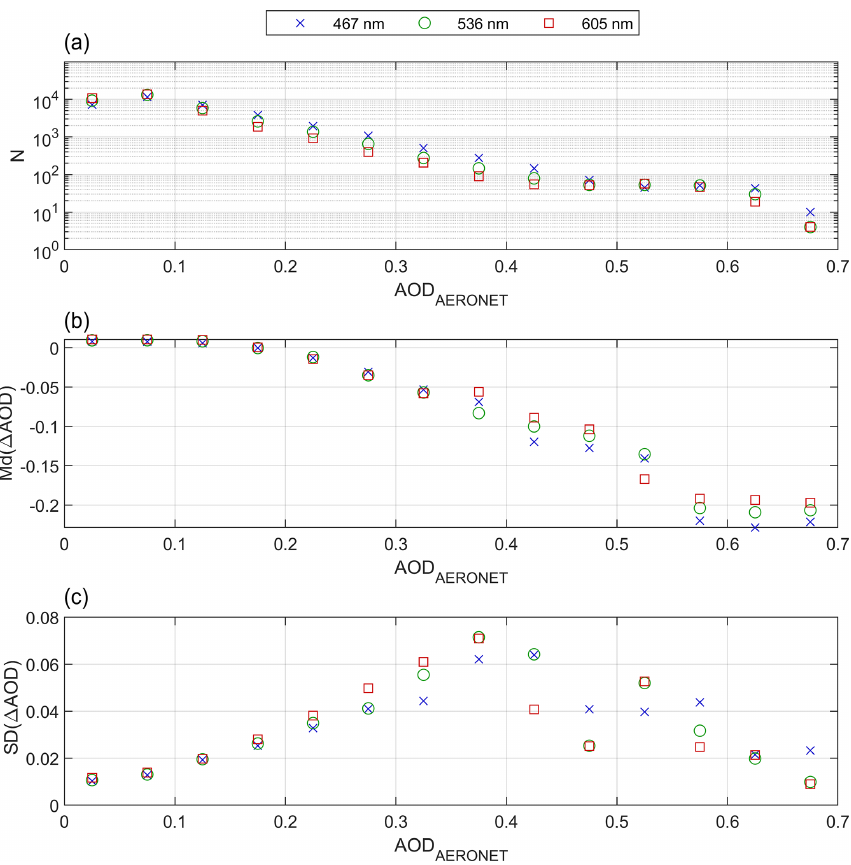
Figure 10. Median (Md; b ) and standard deviation (SD; c ) of the (cid:49) differences in the aerosol optical depth (AOD) retrieved by GRASP with the single-pixel approach (GRASP-CAM) and those obtained by AERONET at 467, 536 and 605nm for different AOD bins. The available amount of (cid:49) AOD data (N) per AOD bin is also shown in (a) for the three